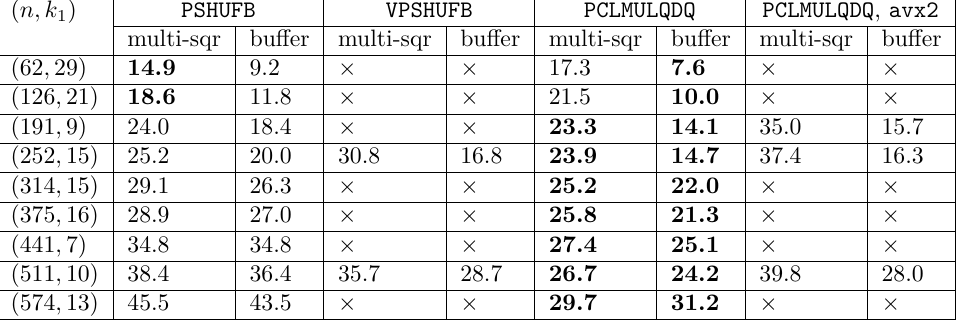
Table 9: Number of cycles to compute the squaring in F 2 n in function of the enabled instructions, with MQsoft . We use a Skylake processor